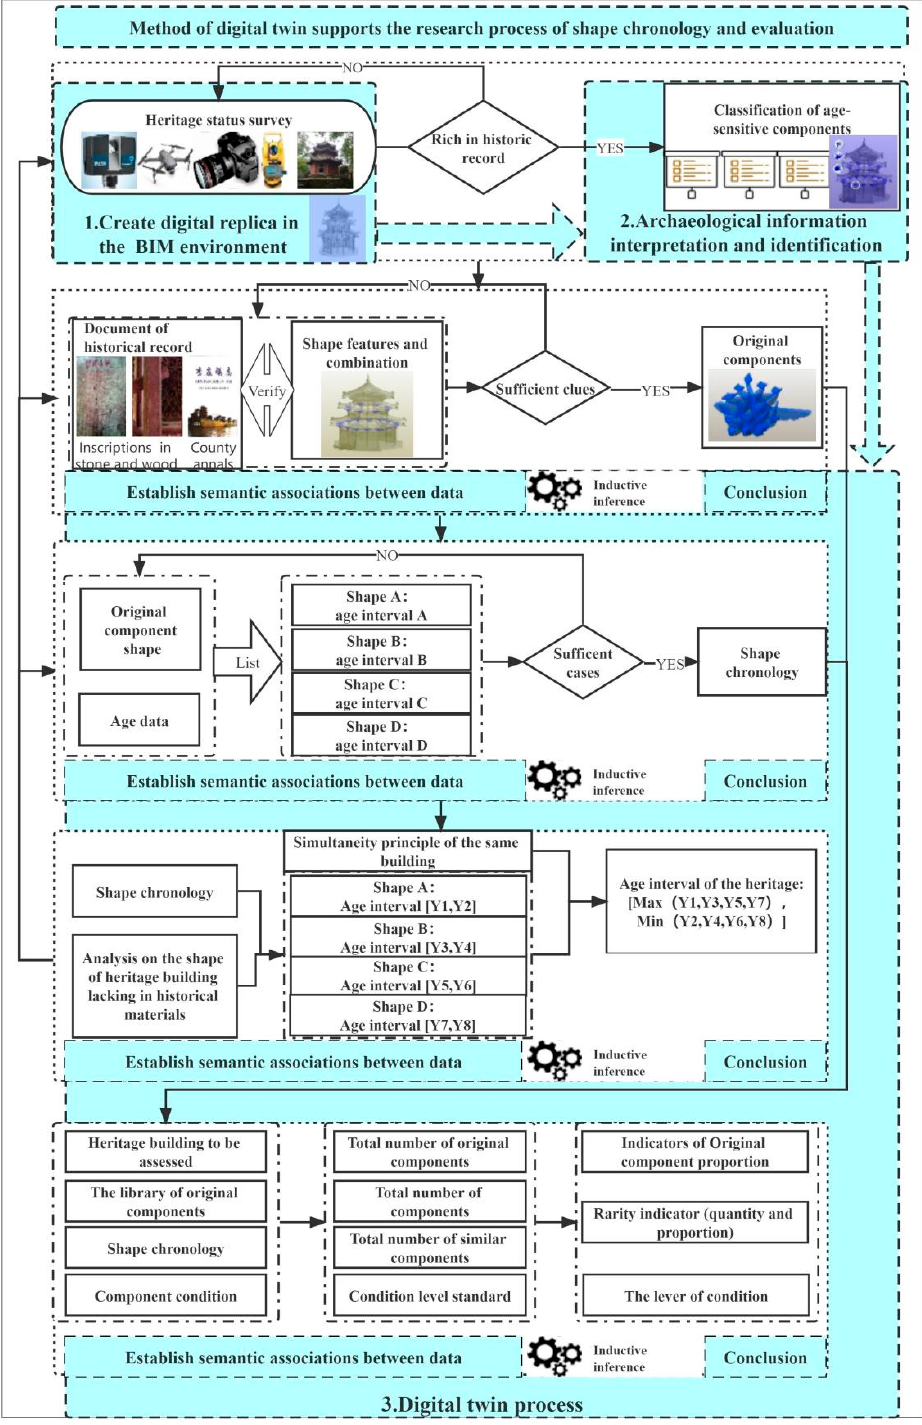
Figure 11. Three steps in the digital twin method to support archaeological